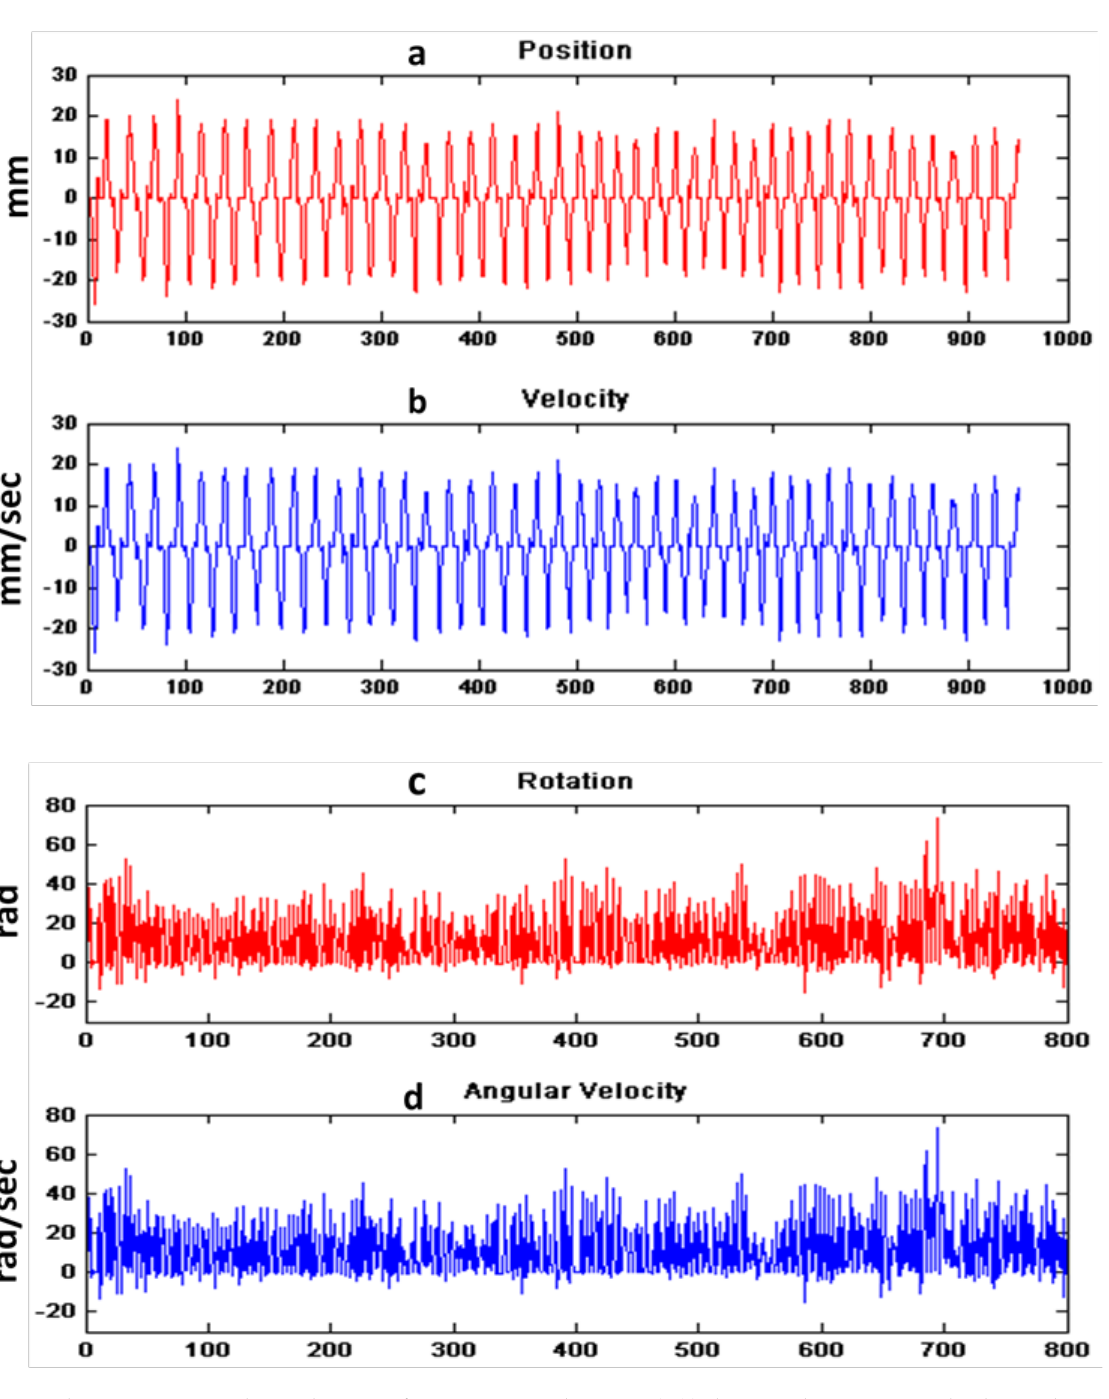
Figure 7. Robotic response to the application of 3D porous tactile sensor ( a , b ) showing the position and velocity changes in the pushing process; ( c , d ) the rotation and angular velocity changes in the process of the rotation.